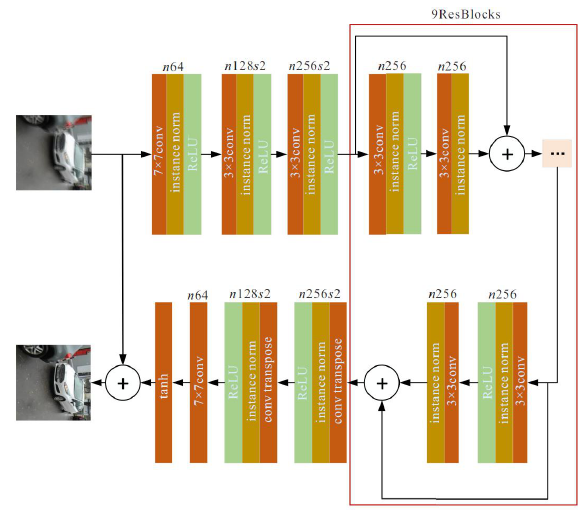
Fig. 3. Generator network structure.